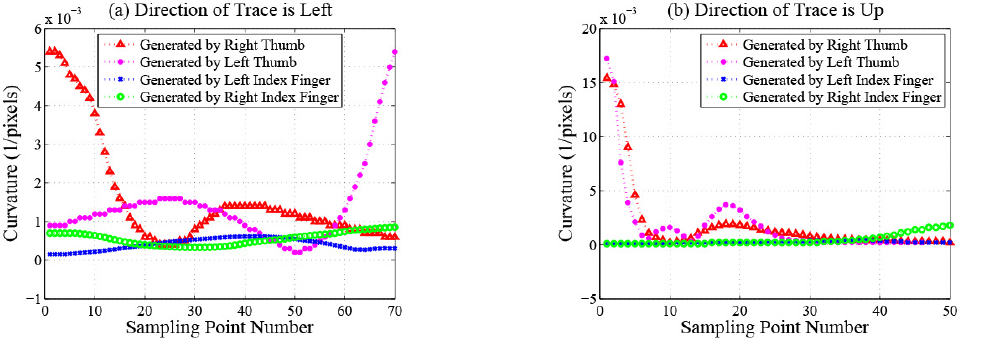
Figure 6. Curvature magnitude of each sampling